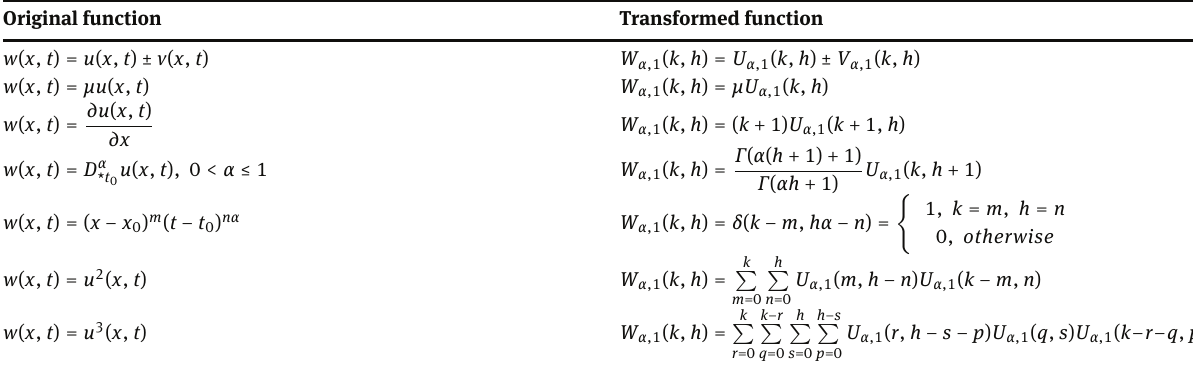
Table 1: The operations for the two-dimensional FDTM. Original function Transformed function